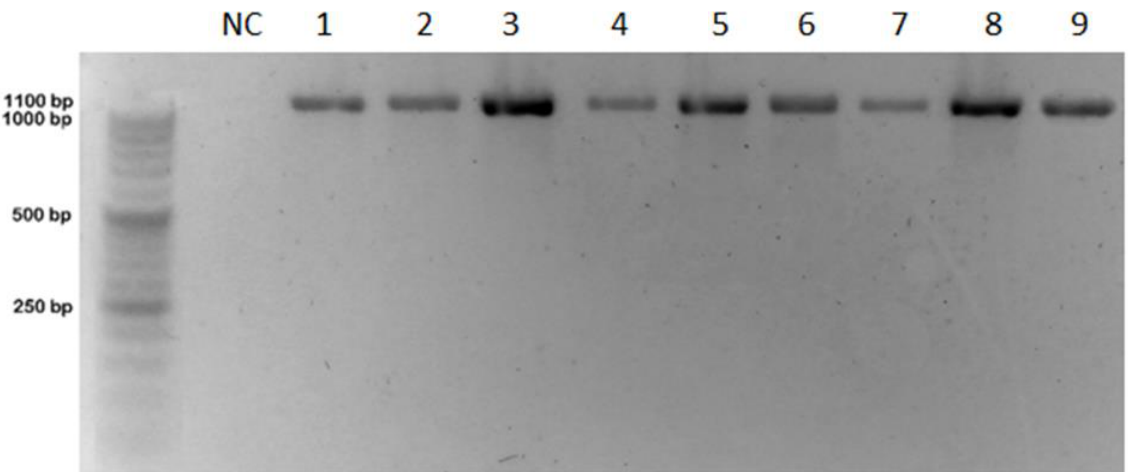
Figure 3. Detection avian reovirus (ARV) by RT-PCR; from left DNA Marker 2+ (100 – 1000 bp, A&A, Gdańsk, Poland), NC — negative control, 1 — liver, 2 – spleen, 3 - bursa of Fabricius 4 — joints, 5 — tendon, 6 — tendon sheath, 7 — heart, 8 — kidney, 9 — intestines; PCR product size 1100 bp.